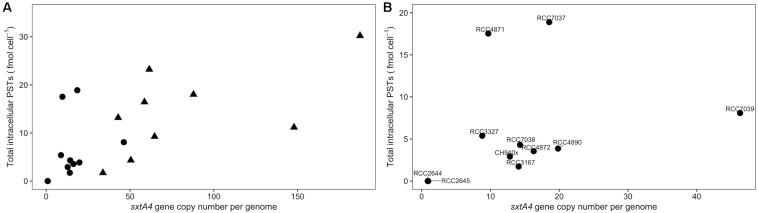
Scatterplots of the relationship between (A) the total intracellular toxins and the sxtA4 copy number per genome in all of the strains (ρ = 0.58, S = 15085, p = 1.5 × 10– 6), and (B) specifically for A. minutum (ρ = 0.65, S = 3308, p = 0.009).